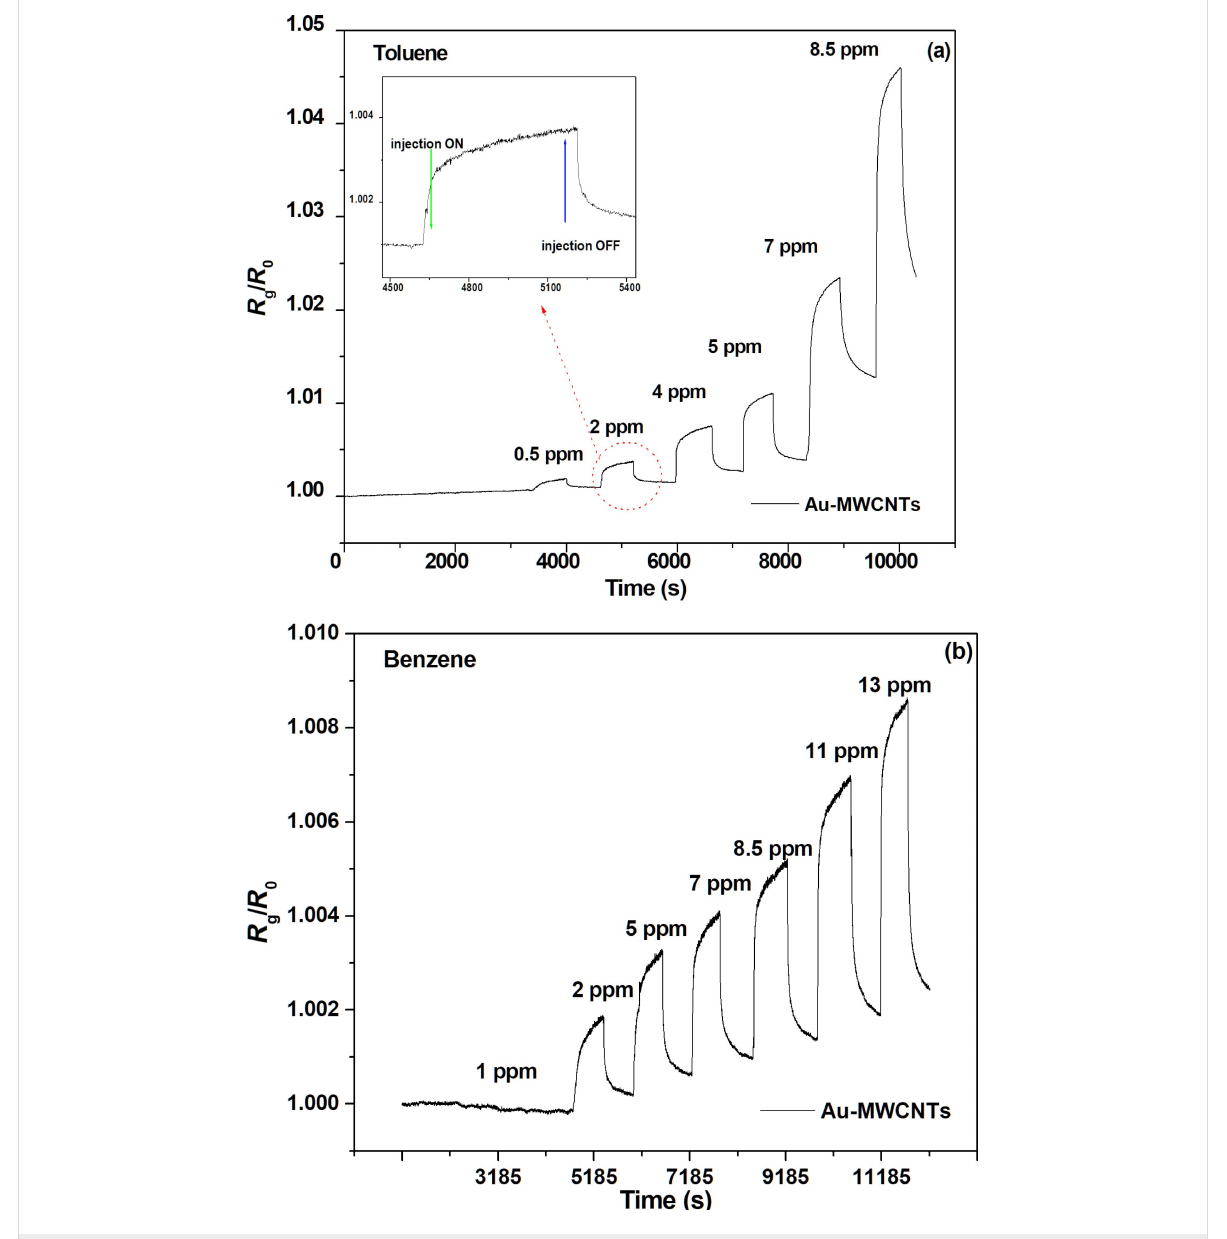
Figure 4: Au-MWCNT sensor response for different concentrations of the injected vapours of (a) toluene and (b) benzene.